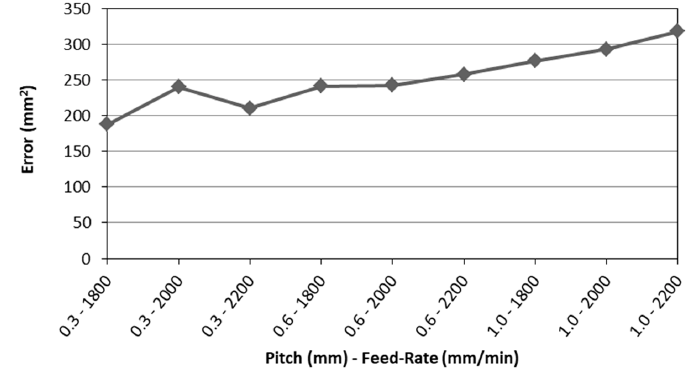
Figure 10. Area between real and theoretical profiles (global error).